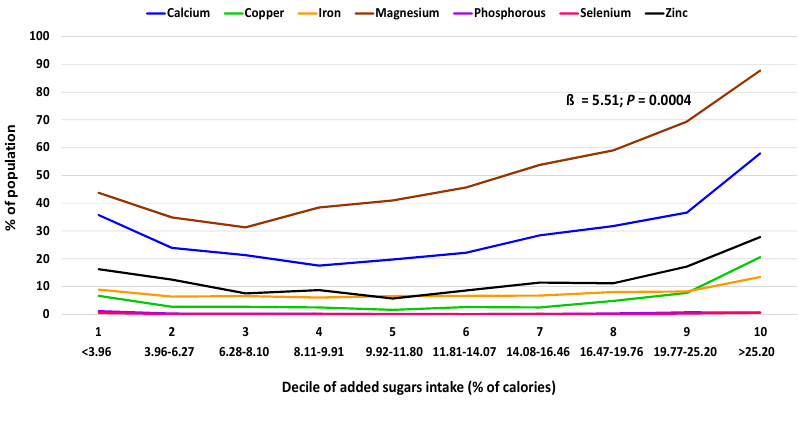
Figure 1. Percentage of adults 19 + y (NHANES 2009–2014) with micronutrient intakes below the EAR for ( A ) minerals and ( B ) vitamins per decile of added sugars intake (% of calories) averaged across two days of intake using regression analysis (ß: regression coefficient). Association deemed significant at p < 0.01. EAR, Estimated Average Requirement; Vit, vitamin.